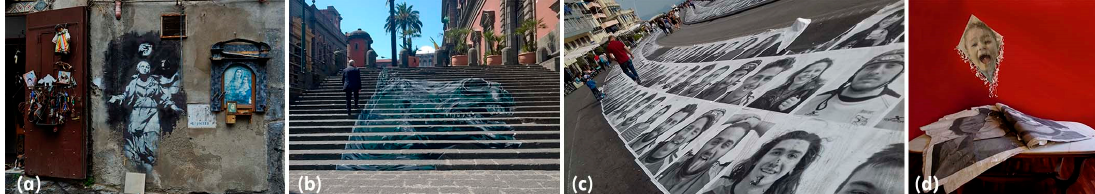
Figura 7. ( a ) Bansky; ( b ) David Diavù Vecchiato; ( c ) JR Artist; ( d ) Rita Esposito & Daniele